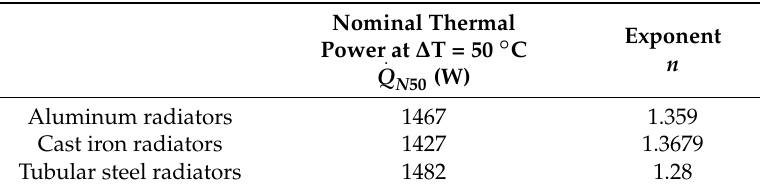
Table 3. Characteristic coefficients of water